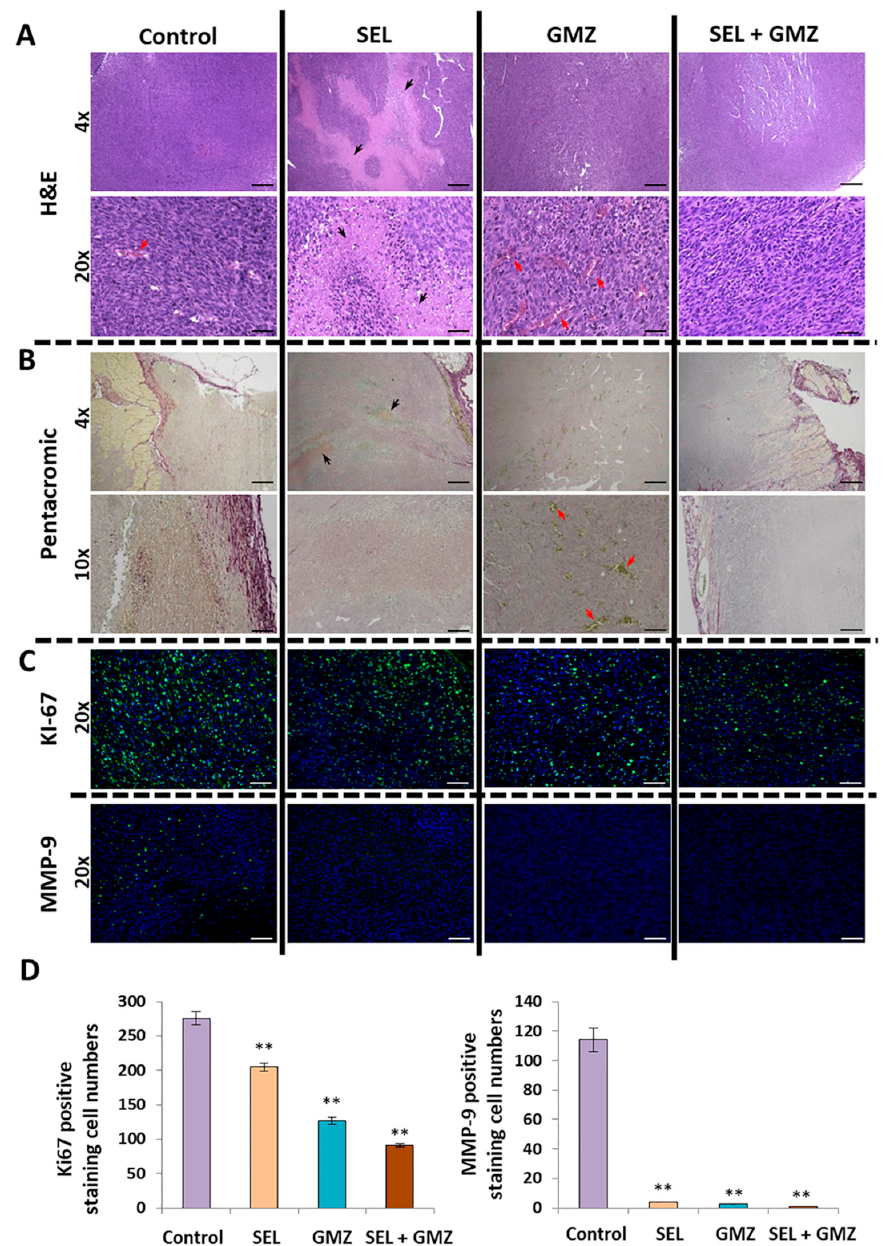
Figure 7. Histological analysis of resected tumors by histological basic staining and immunofluorescence. ( A ) Stained hematoxylin–eosin samples from the different treatment groups (4 × and 20 × magnification). ( B ) Samples stained with the new pentachromic method at 4 × and 10 × . This method highlights the visualization of blood vessels with red blood cells in yellow inside and thin layers of intimal collagen. ( C ) Immunofluorescence staining for Ki67 and MMP9 at 20 × . ( D ) Graphical representation of immunofluorescence positive staining quantification by Image J. Data are presented as mean ± standard deviation of three independent experiments; ** p < 0.01 vs. respective control group. Scale bar 4 × (200 µ M), 10 × (150 µ M) and 20 × (50 µ M). GMZ (gemcitabine); SEL (sodium